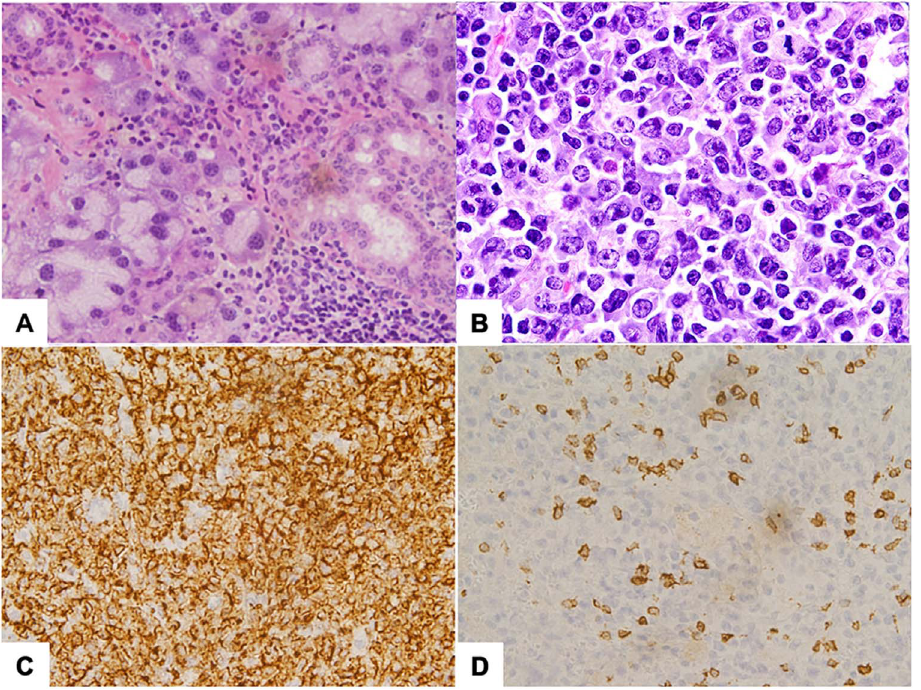
Figure 7. Lymphocytic infiltrates into parenchymal organs and B-cell malignancies in Nfatc2 KO mice. (A) Photomicrograph of a representative section from the parotid salivary gland of a 21-month old Nfatc2 KO mouse stained with H&E (magnification 100X) showing mild to moderate lymphocytic aggregates in the interstitium. Approximately 70% of the infiltrate consisted of B cells. (B) Photomicrograph of a representative section from lymph node of a 20-month old Nfatc2 KO mice stained with H&E (magnification 400X) showing effacement with corticomedullary architecture expanded by a homogenous population of large lymphocytes with large eccentric nuclei containing open to marginated chromatin, single to multiple prominent nucleoli, and scant to moderate amphophilic cytoplasm. The section contains scattered necrotic cells and 0–2 mitoses per high power field. The histological appearance is consistent with plasmablastic plasmacytoma. Similar tumors were identified in lymph nodes, livers, and spleens of Nfatc2 KO mice. (C and D) Immunohistochemical staining using antibodies against B220 (C) and CD3 (D) in serial sections from (B), showing the tumor is comprised by a monotonous population of malignant B cells with few residual T cells.